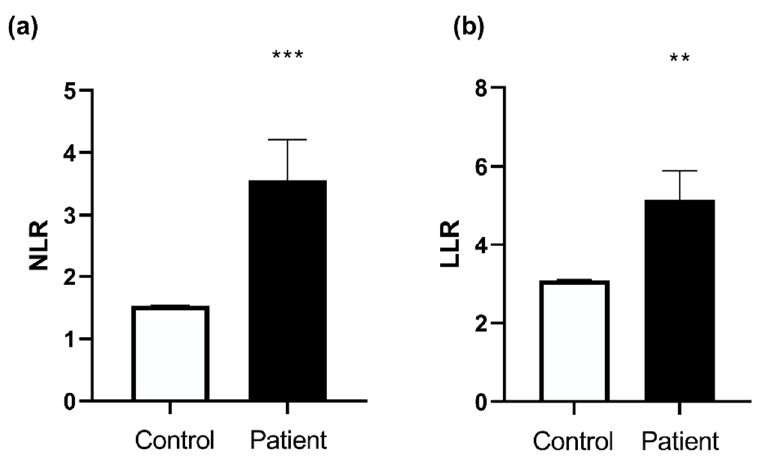
Figure 2. Controls and heart transplant group ratios. ( a ) Neutrophils-to-lymphocyte ratio (NLR), ( b ) Leukocyte-to-lymphocyte ratio (LLR). Values are means ± SEM, ** p < 0.01, *** p < 0.001. n = 20/group.